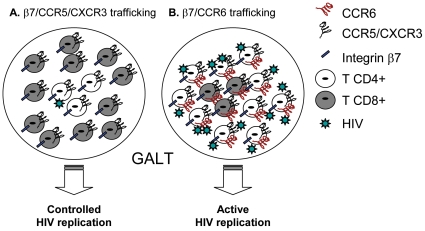
Proposed model for the differential colocalization of HIV-specific CD4+ and CD8+ T-cells into the GALT.The control of viral replication is dependent on the in situ colocalization of excess effector versus target cells [28]. Given the results included in Figures 1–



6 of the present manuscript, we propose a model where (A) HIV replication in CD4+ T-cells may be controlled by CD8+ T-cells in certain GALT sites (e.g., lamina propria), where recruitment is dependent on integrin β7, CXCR3 and CCR5 because of an increased ratio between HIV-specific CD8+ and CD4+ T-cells. In contrast, (B) HIV-specific CD4+ T-cells recruited into other GALT sites via CCR6 (e.g., Peyers's Patches) may escape the CD8+ T-cell-mediated antiviral control due to a limited CCR6-dependent colocalization potential of CD4+ and CD8+ T-cells. This model is in line with our previous findings that CCR6+CD4+ T-cells harbor the highest levels of integrated HIV-DNA in vivo
[44] and suggests that novel therapeutic strategies aimed at increasing CCR6 expression on CD8+ T-cells may lead to a better control of HIV replication in CCR6+CD4+ T-cells.